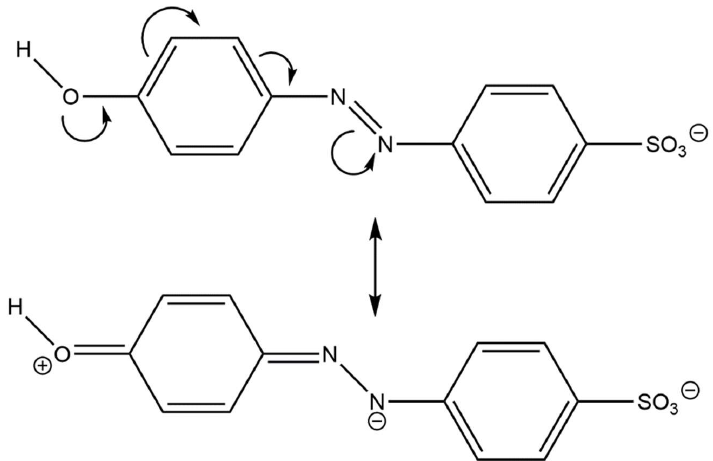
Figure 10. Packing view of the 2-dimensional coordination polymer [Na 2 ( 1* )(OH 2 ) 4 (acetone)], viewed down the crystallographic a direction and showing interdigitation of three polymeric units. H atoms omitted for